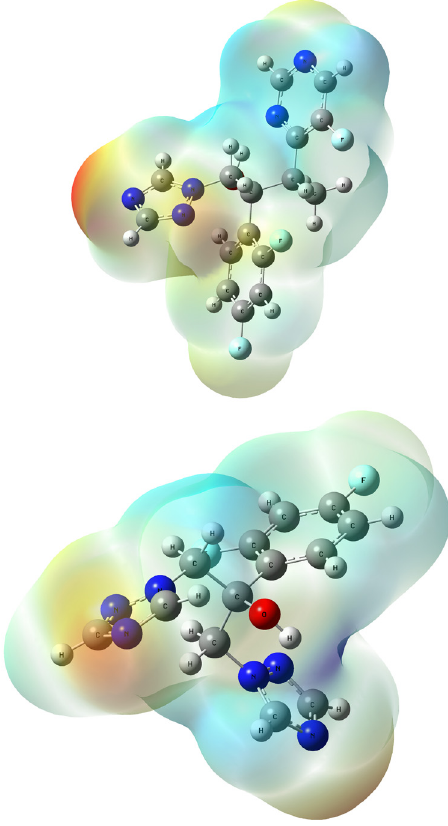
Figure 2: ESP map of compounds 1 ( up ) and 2 ( down ) calculated at the B3LYP/6 - 311 ++ G ( 2d,3p ) //B3LYP – 6311 ++ G ( d,p ) or M06L/6 - 311 + + G ( 2d,3p ) //M06L – 6311 ++ G ( d,p ) levels of theory ( 2 ) levels of theory; gaseous phase; isovalue = 0.0004 a.u.; scale: red – blue from − 6.243 × 10 − 2 to + 6.243 × 10 − 2 .